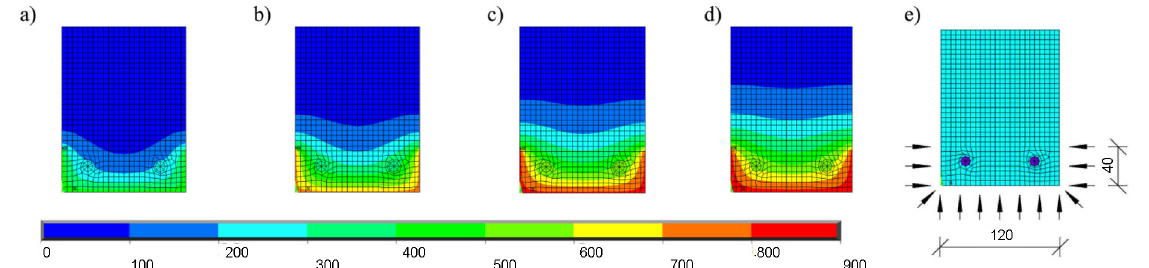
Fig. 10. Calculated isotherm layout in the cross section (120×160 mm) of the beam: a) heating duration – 15 min, b) 30 min, c) 45 min, d) 60 min, e) a part of the beam face exposed to high